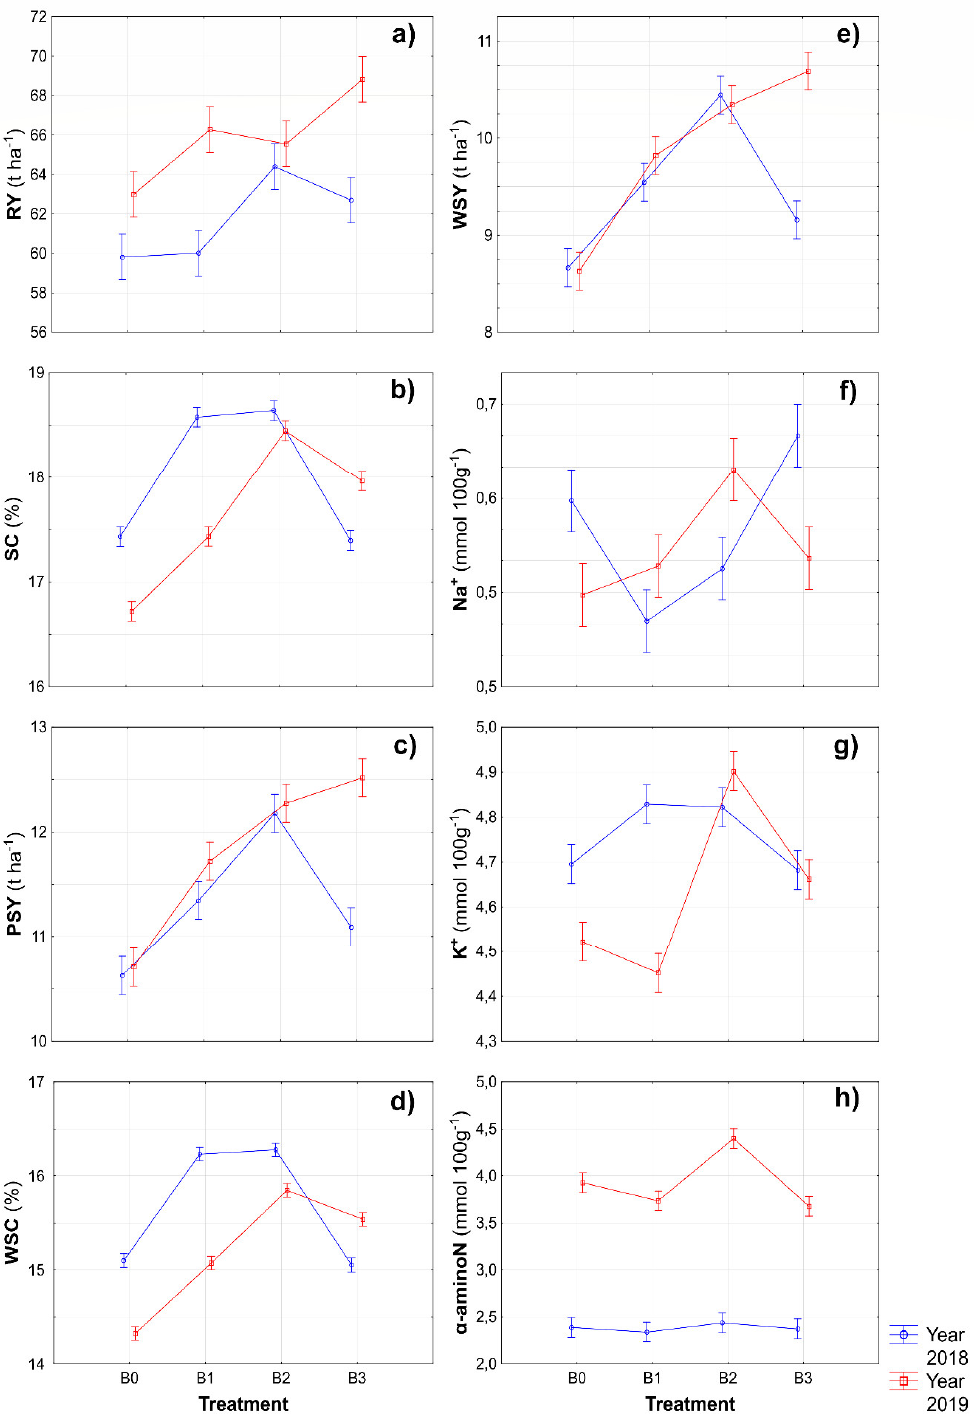
Figure 3. Interactions between biostimulants and experimental years for root yield ( a ), sugar content ( b ), polarized sugar yield ( c ), white sugar content ( d ), white sugar yield ( e ), sodium content ( f ), potassium content ( g ) and α-aminonitrogen content ( h ). B0—control; B1—humic acids, essential amino acids; B2—essential amino acids biopolymers, soil bacteria; B3—humic acids, essential amino acids biopolymers, soil bacteria Figure was obtained at a level of significance α = 0.05.